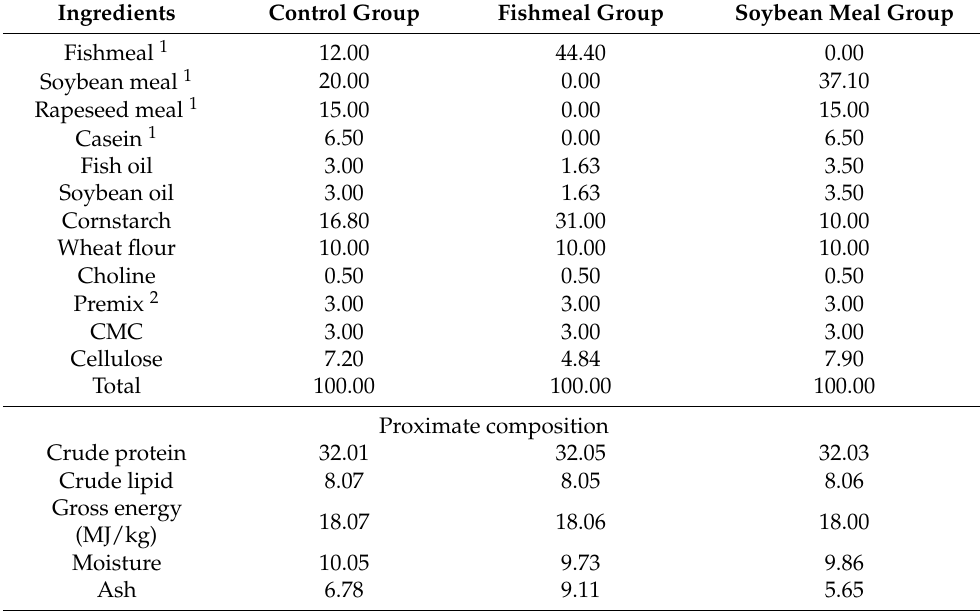
Table 2. Formulation of different dietary protein sources (% dry matter).